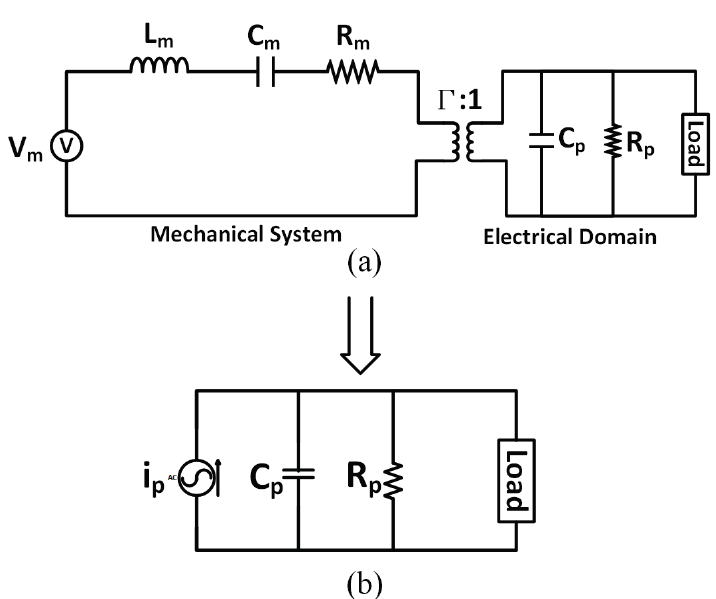
Figure 3. ( a ) Electromechanical model of the piezoelectric device; ( b ) Uncoupled equivalent circuit of a piezoelectric device considering dielectric losses associated to C p